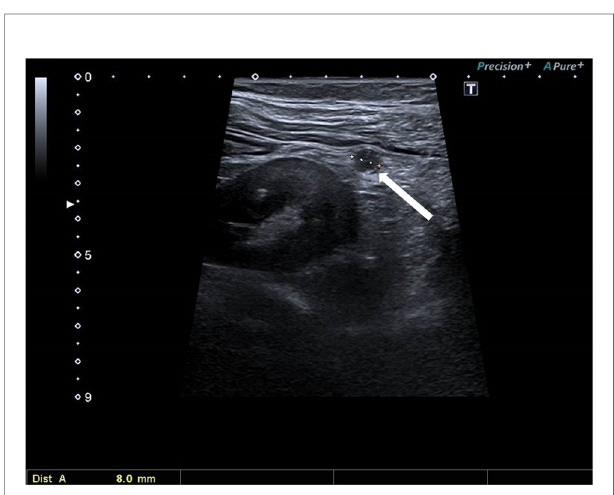
FIGURE 2 | 8 mm metastasis within the left perirenal fat. Ultrasonographic